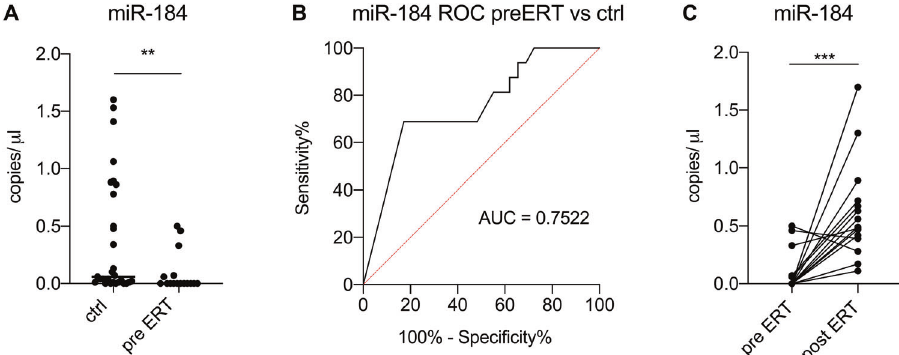
Fig. 1 miR-184 as a biomarker in AFD. A Circulating levels of miR-184, measured by ddPCR, in AFD patients before starting treatment (pre- ERT) and in healthy controls (ctrl) ( N = 16 pre-ERT patients; N = 29 healthy controls). ** P < 0.05 (non-parametric Mann – Whitney test). B ROC curve and relative area under the curve calculation for miR-184 as a biomarker of AFD. C miR-184 is modulated by ERT. The circulating level of miR-184, measured by ddPCR, in 16 AFD patients before (pre-ERT) and after (post-ERT) the start of ERT. *** P = 0.0004 (non-parametric Wilcoxon matched-paired signed-rank test).